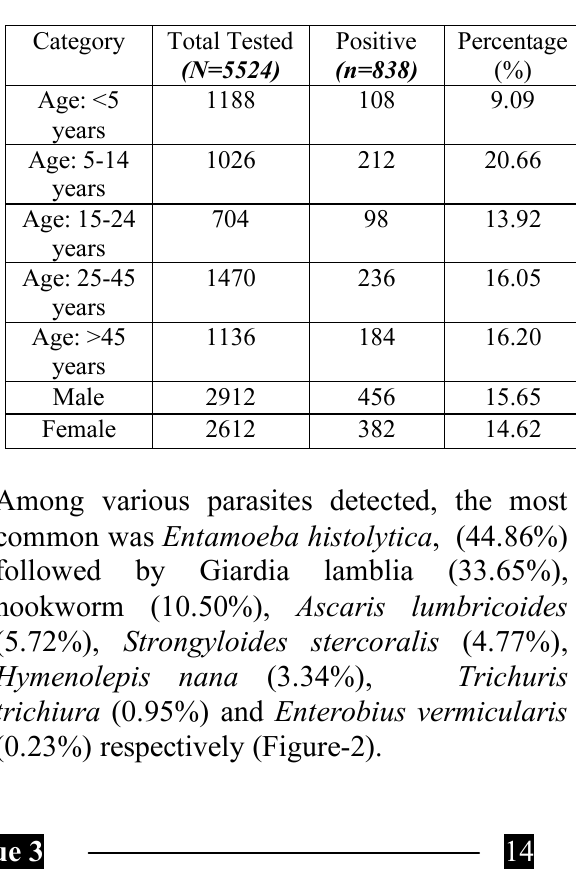
Table 1: Age and gender wise distribution of positive